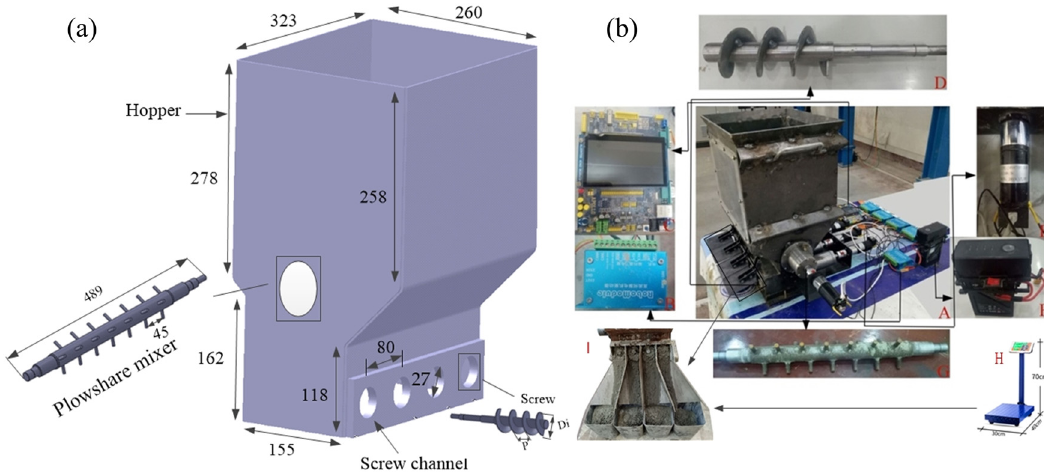
Figure 15: The 3D geometric model of screw conveyor ( a ) and the experimental equipment ( b ) . It consists of nine parts: screw conveyor ( A ) ; controller ( B and C ) ; screw ( D ) ; motors ( E ) ; power ( F ) ; plowshare mixer ( G ) ; scale ( H ) ; and guide plate ( I ) .